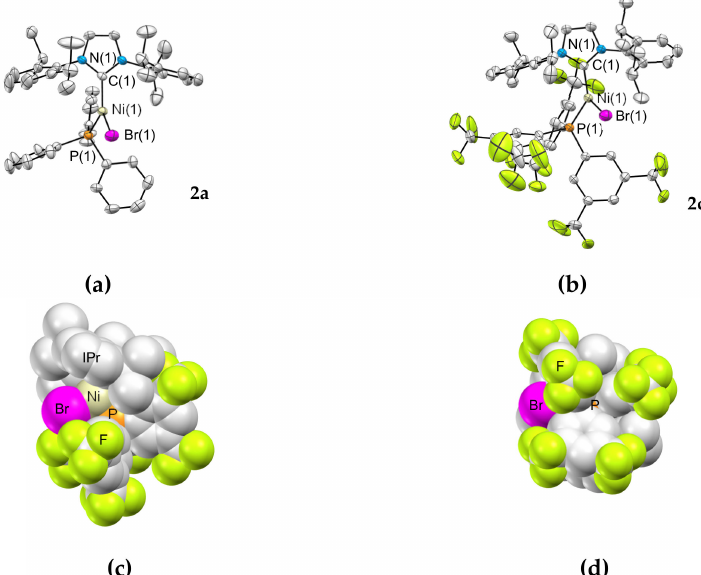
Figure 1. ORTEP drawing of ( a ) 2a and ( b ) 2c (50% probability of thermal ellipsoids. Hydrogen atoms and solvent molecule (THF in the crystal of 2c ) are omitted for clarity). Views of space-filling model of 2c from ( c ) the side and ( d ) the bottom are illustrated (pink: Br; gray: C; light green: F; orange: P; light yellow: